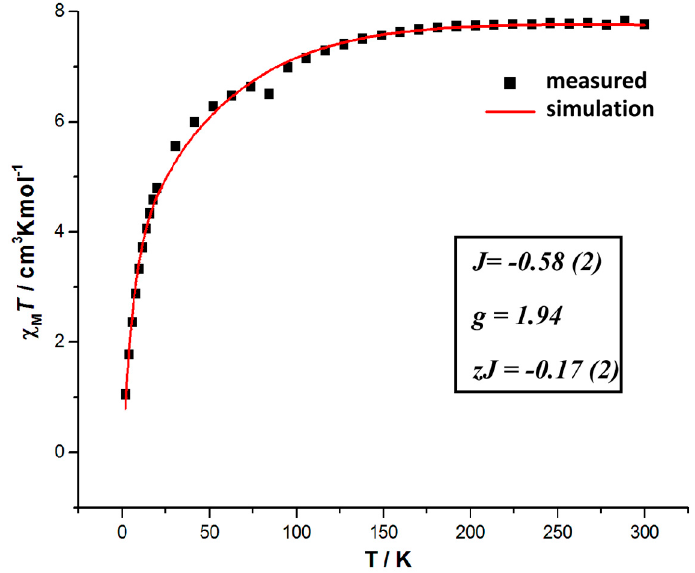
Figure 8. The FT-IR spectra of ligand pyrtrz and compounds 1 , 2 .